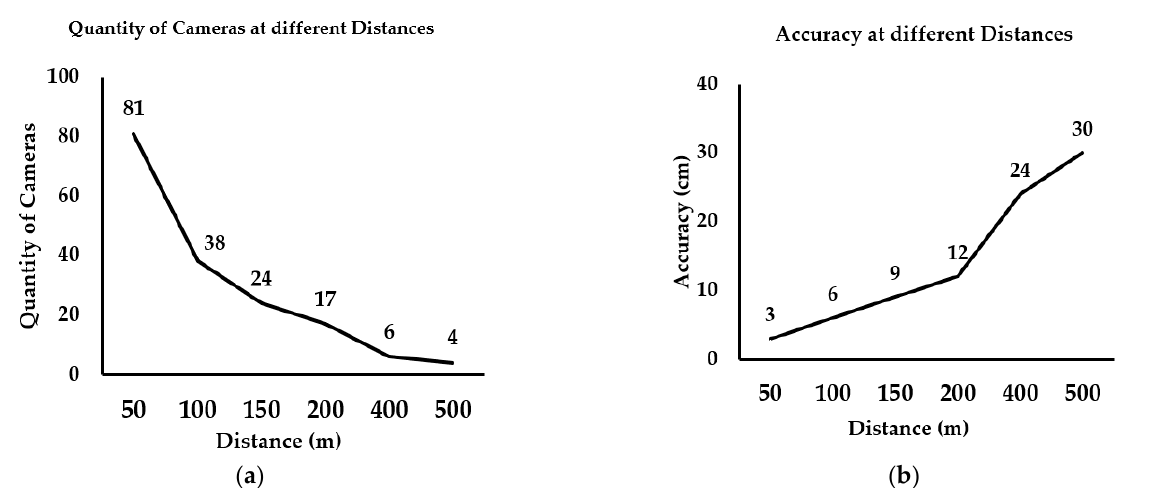
Figure 10. Quantity and accuracy of cameras at different distances. ( a ) The minimum quantity of cameras calculated for different distances. The further the distance, the fewer the cameras needed. ( b ) The distance each pixel represents in the field increases, which means that the accuracy decreases.